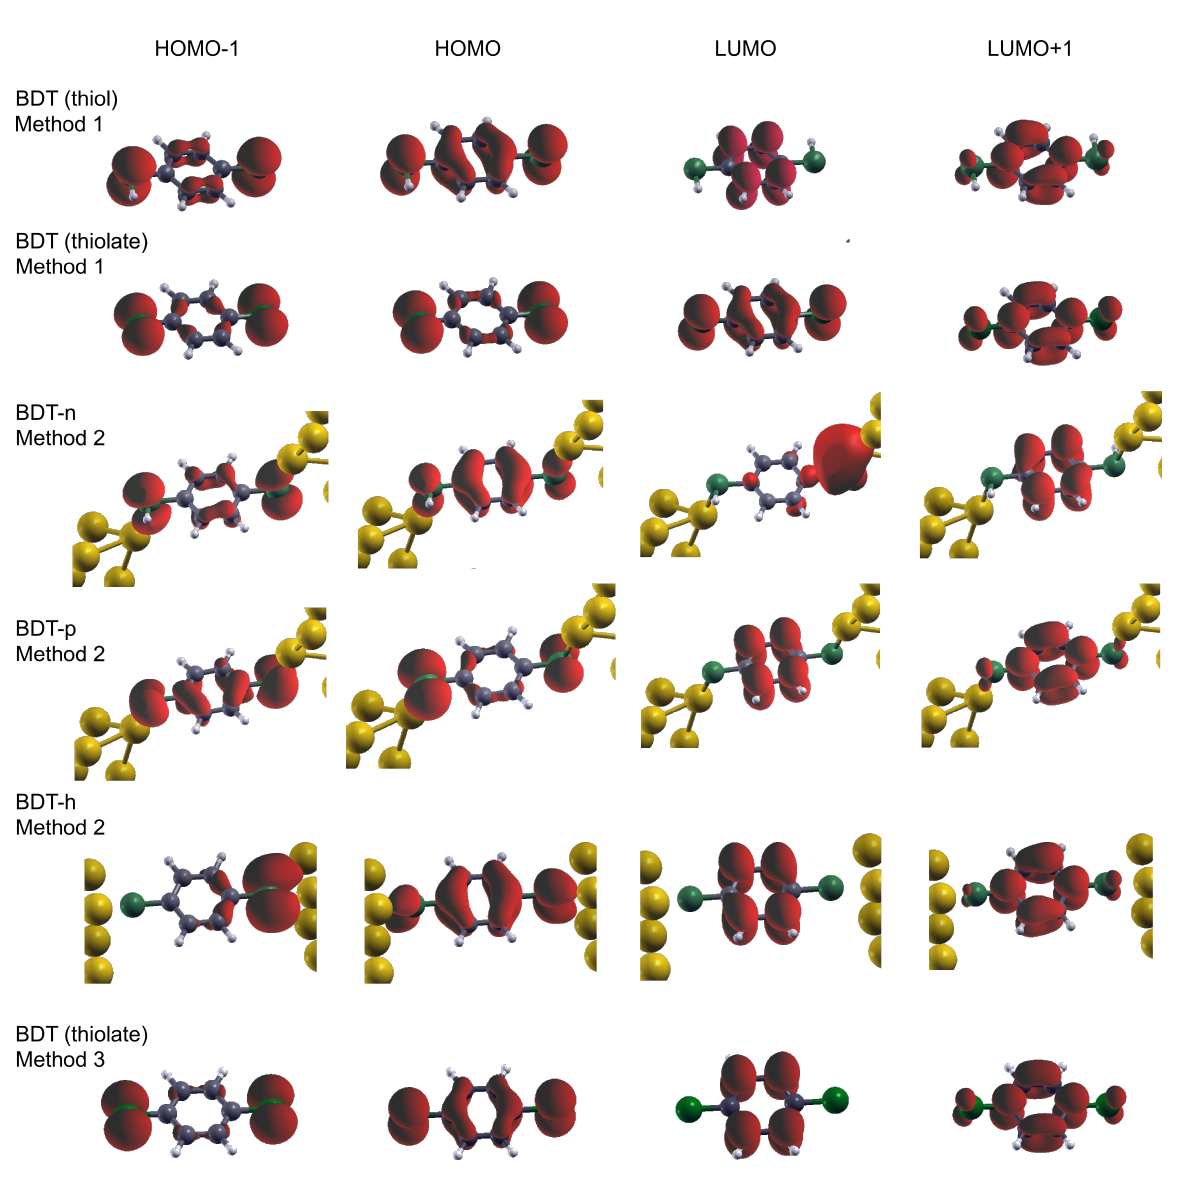
Figure 4: Electronic density isosurfaces (red) of the HOMO − 1, HOMO, LUMO and LUMO+1 molecular orbitals of BDT as obtained with the two tradi- tional methods as well as with the new method (see text). For Method 1, the dithiol and dithiolate molecules are considered. For Method 2, the different molecular junction geometries (BDT-n, BDT-p and BDT-h) are examined. For Method 3, a charge of +0.5 e − was added to the dithiolate mole- cule in order to account for the transfer of charge to the molecule from gold atoms in the BDT-h junction. The resulting orbitals are very similar to those obtained with Method 2 for BDT-h. Hydrogen, carbon and nitrogen atoms are represented by white, grey and brown spheres,